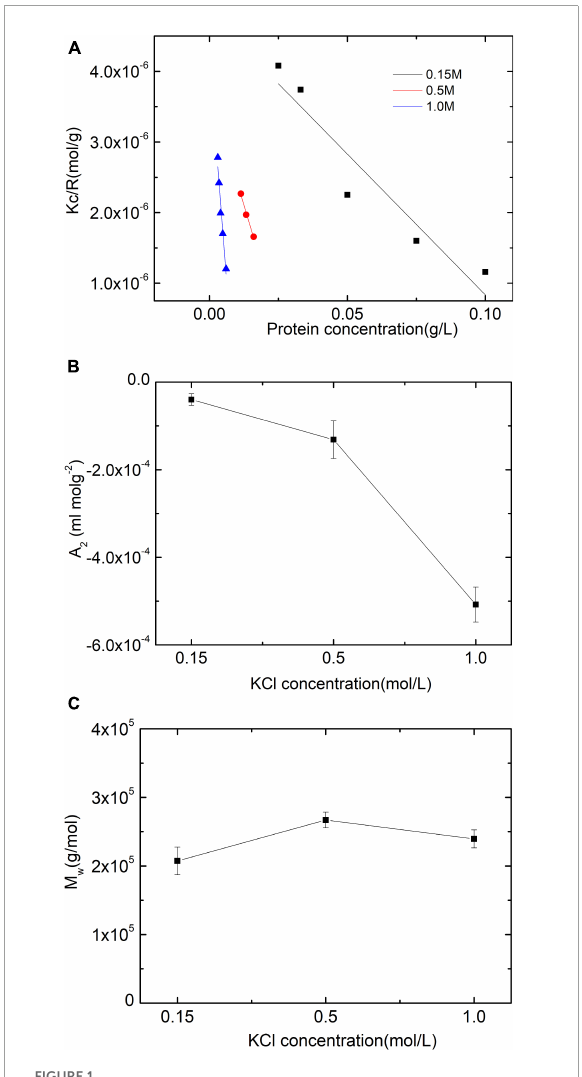
FIGURE1 Static light scattering (SLS) assessments of paramyosin. (A) Debye plots of paramyosin solutions under three salt concentrations. (B,C) Are the corresponding second virial coefficient A 2 and the molecular masses of protein Mw